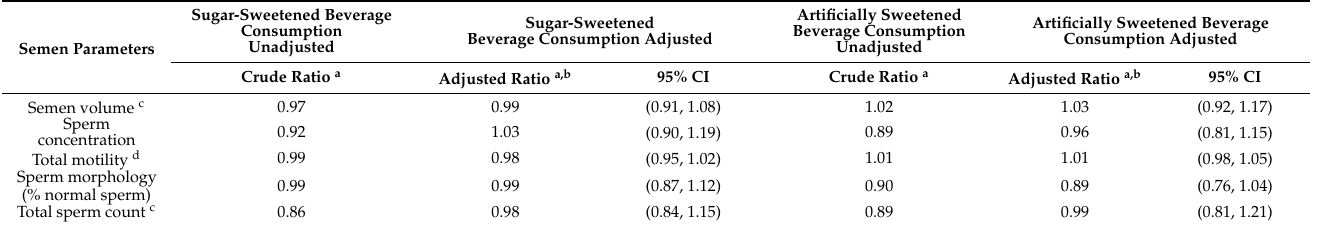
Table 3. Crude and adjusted outcome ratios according to sugar-sweetened and artificially sweetened beverage consumption among participants, FEPOS 2017–2019.